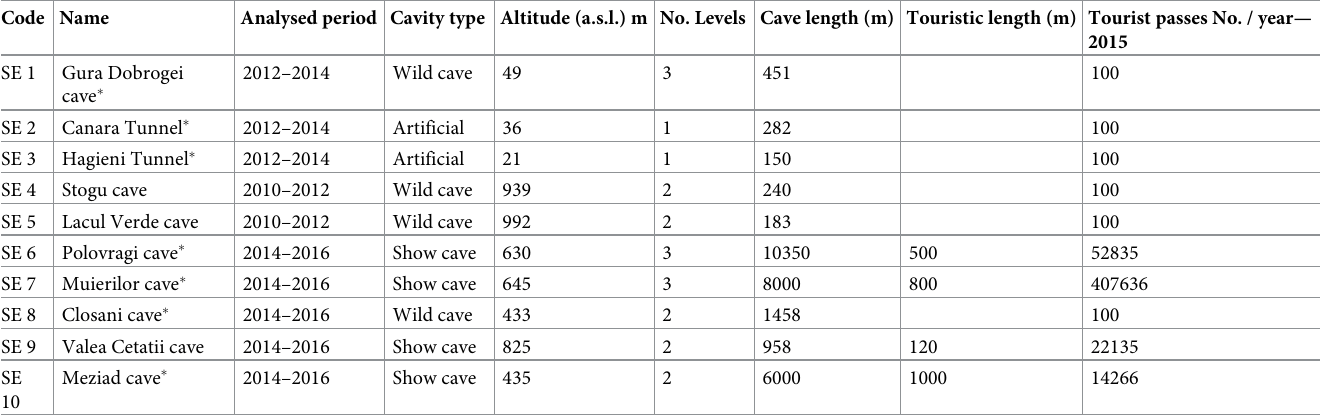
Table 1. Details regarding the studied subterranean environments. Code